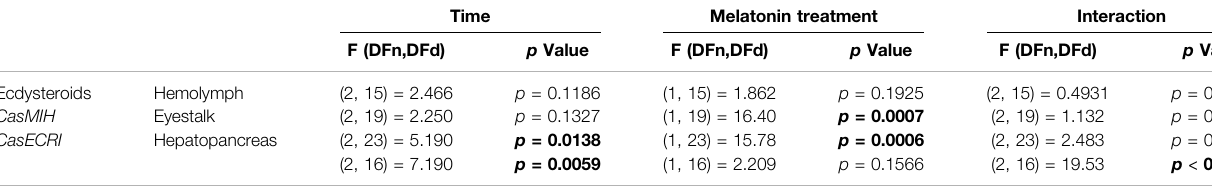
TABLE 3 | ANOVA parameters related to gene expression and hormone concentrations in melatonin-injected crabs. Time Melatonin treatment